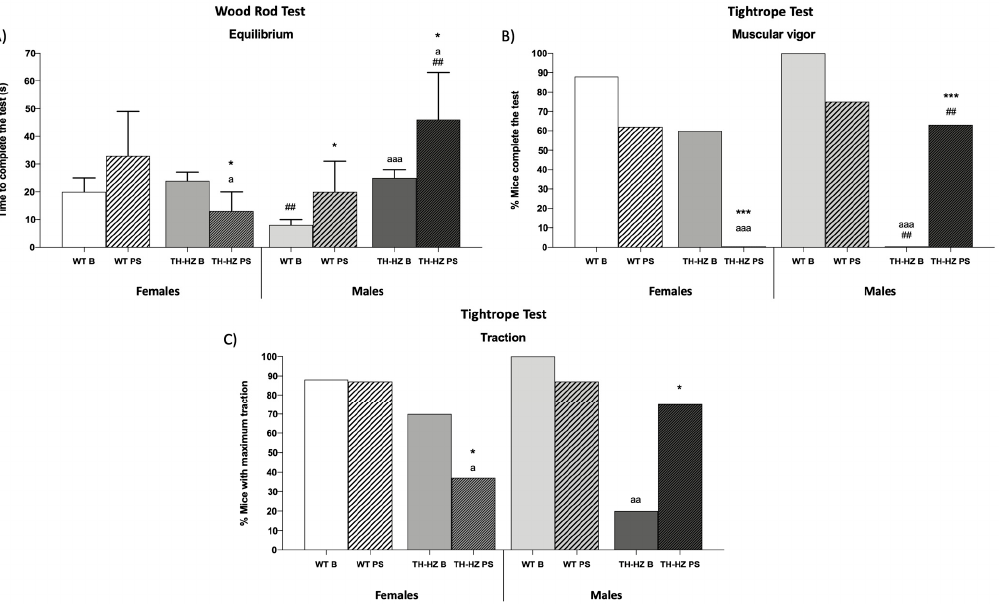
Figure 1. Sensorimotor abilities. ( A ) Time (in seconds) to complete the wood rod test. ( B ) Percentage (%) of animals that completed the tightrope test. ( C ) Percentage (%) animals that performed the tightrope test with the maximum traction. Each column represents the mean ± standard deviation of values corresponding to 6 animals. * p < 0.05, *** p < 0.001 compared to basal condition, a p < 0.05, aa p < 0.01, aaa p < 0.001 compared to WT. ## p < 0.01 compared to female. WT B: Wild type basal. WT PS: Wild type post-stress. TH-HZ B: TH-HZ basal. TH-HZ PS: TH-HZ post-stress.